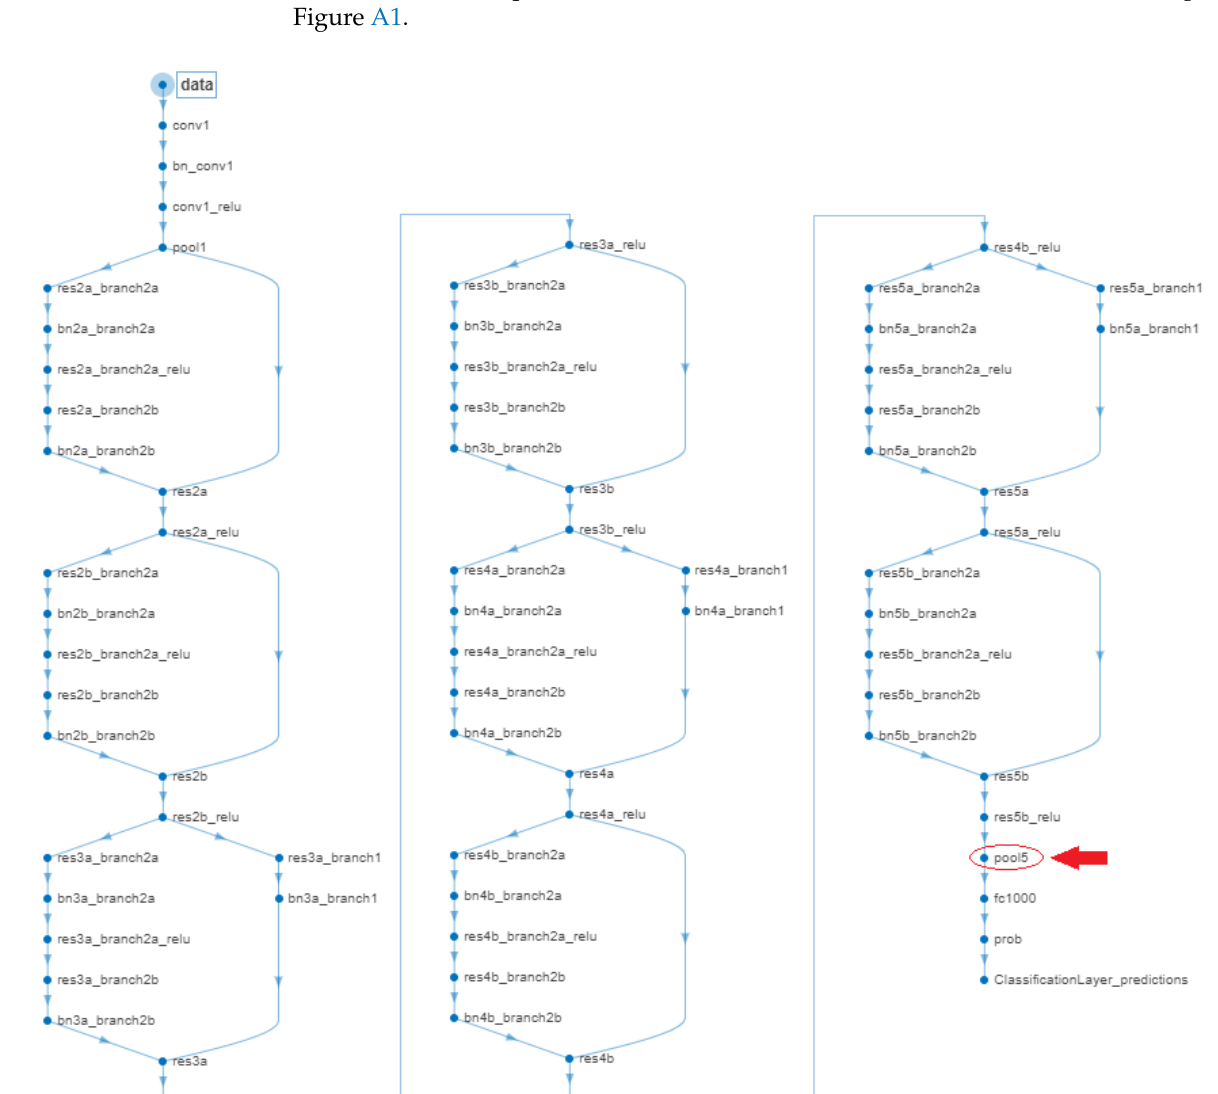
Figure A1. Diagram of ResNet18 with highlighted “pool5”